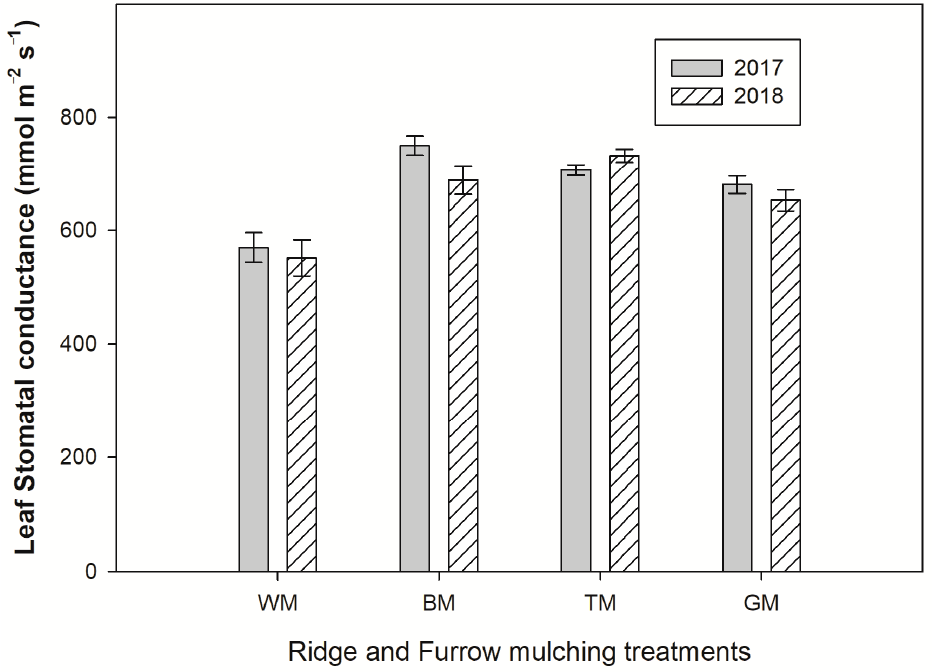
Figure 8. Influence of different ridge and furrow mulching treatments on leaf stomatal conductance of maize in 2017 and 2018. WM = Ridge-furrow without mulch, BM = Ridge-furrow covered with black plastic mulch, TM = Ridge-furrow covered with transparent plastic mulch, GM = Ridge-furrow covered with grass mulch .